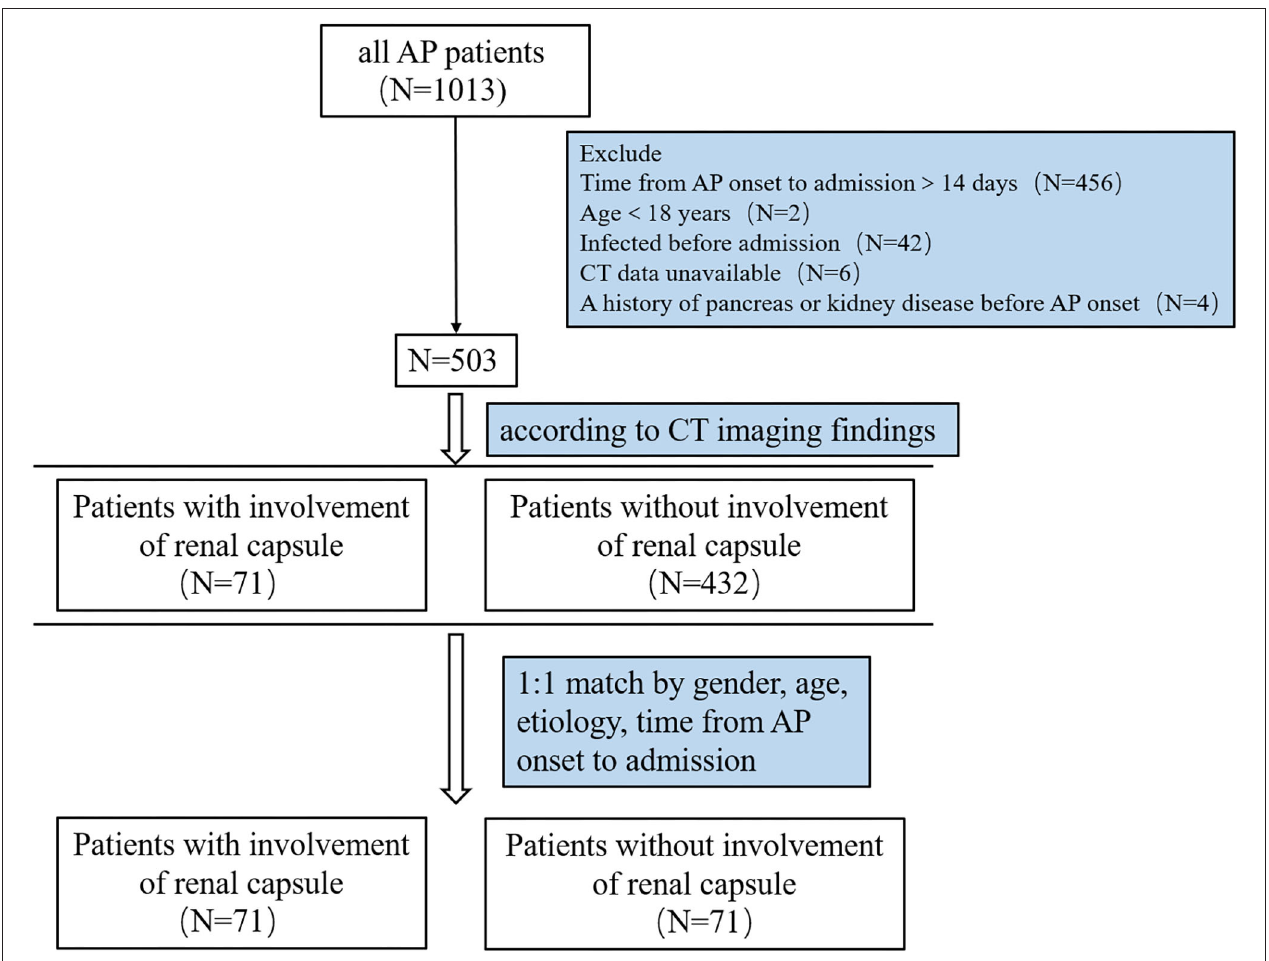
FIGURE 1 | Flow chart of patients with AP in the study. AP, acute pancreatitis; CT, computed tomography.